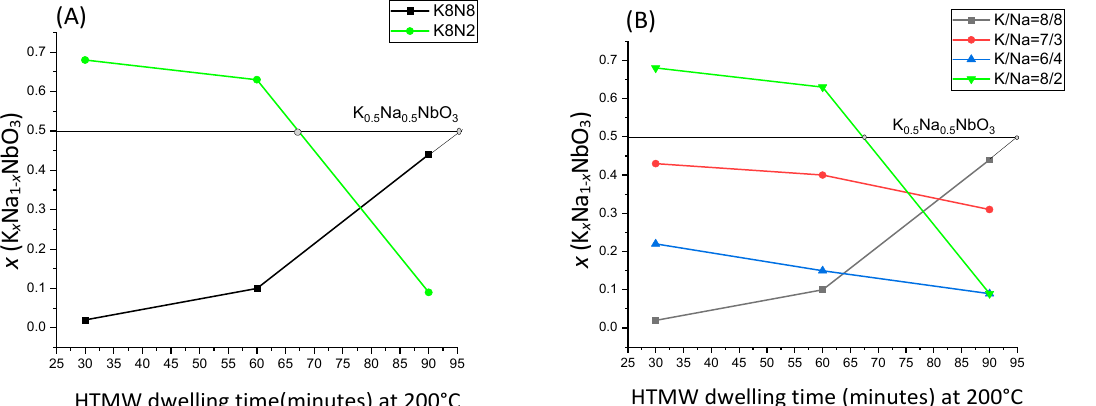
Figure 1. Solid solution K x Na 1 − x NbO 3 molar fraction x variation depending on HTMW dwelling time (30–90 min) at maximum temperature 200 °C, for different alkaline precursor mix molar rates. ( A ) K8N8 sample vs. K8N2 (KOH-8M); ( B ) samples K7N3, K6N4 and K8N2 (KOH + NaOH = 10M). The targeted KNN (K 0.5 Na 0.5 NbO 3 ), at the same KOH/NaOH ratio and